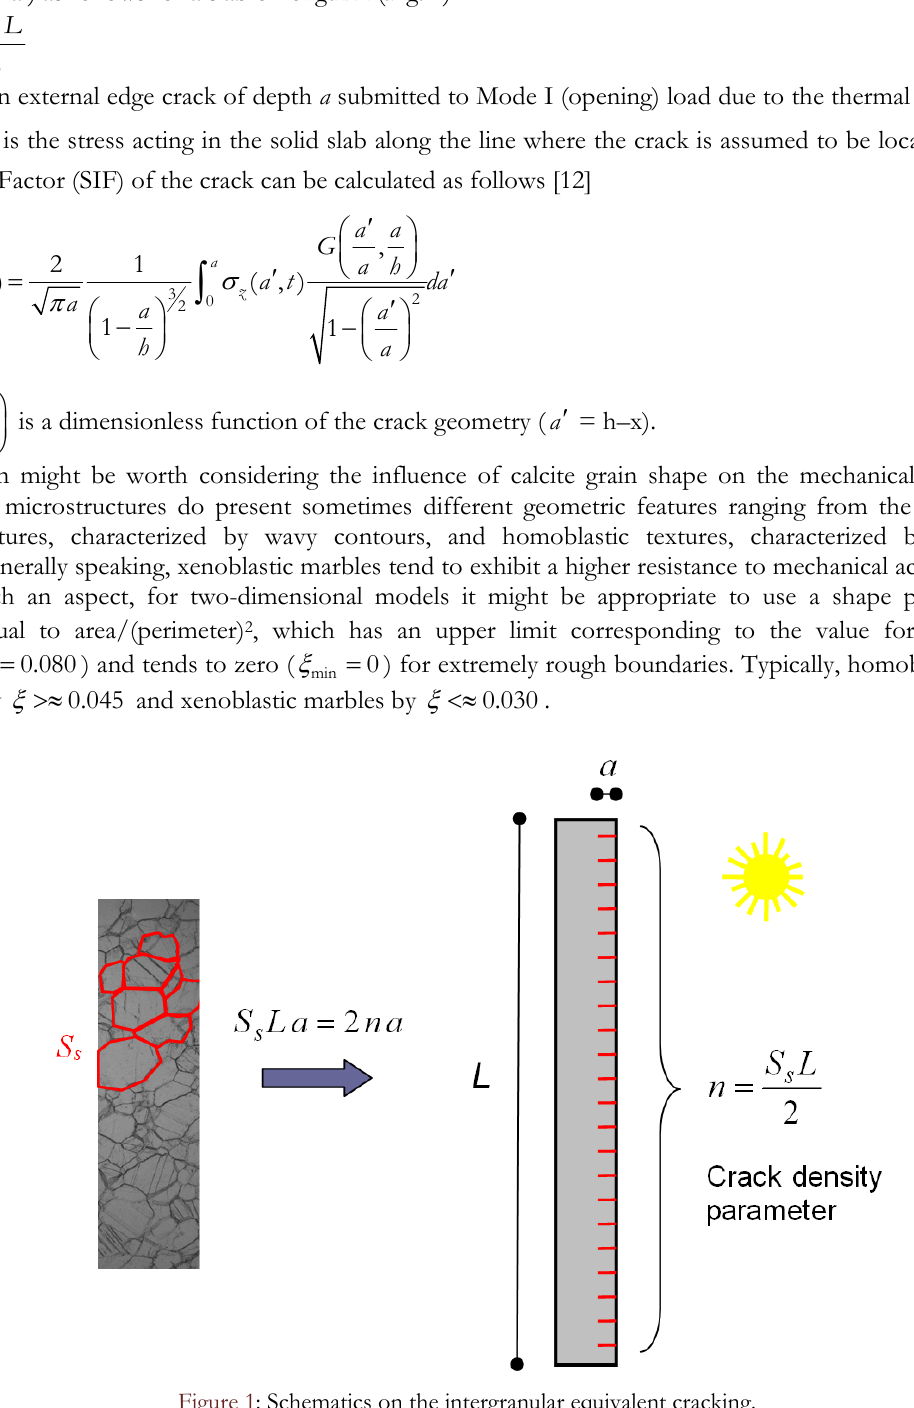
Figure 1: Schematics on the intergranular equivalent